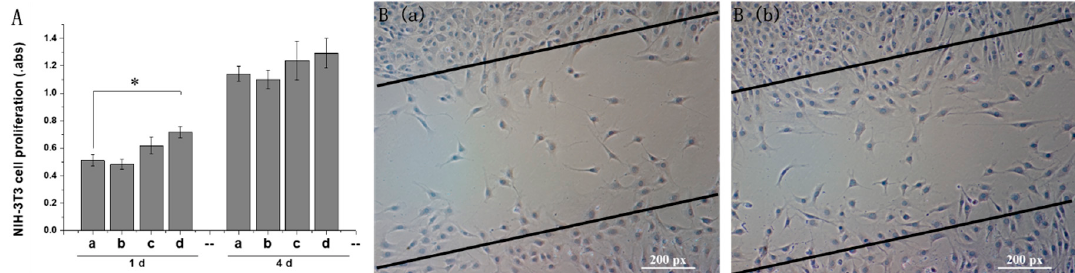
Figure 6. The ADSCs-seeded PVA dressings promoted NIH-3T3 cell proliferation and migration. ( A ) Cell Counting Kit-8 (CCK-8) test of NIH-3T3 proliferation covered with different dressings for 1 d and 4 d: control (a); Az-Gel@PVA dressing without ADSCs seeded (b); Az-Gel@PVA dressings with 3 × 10 5